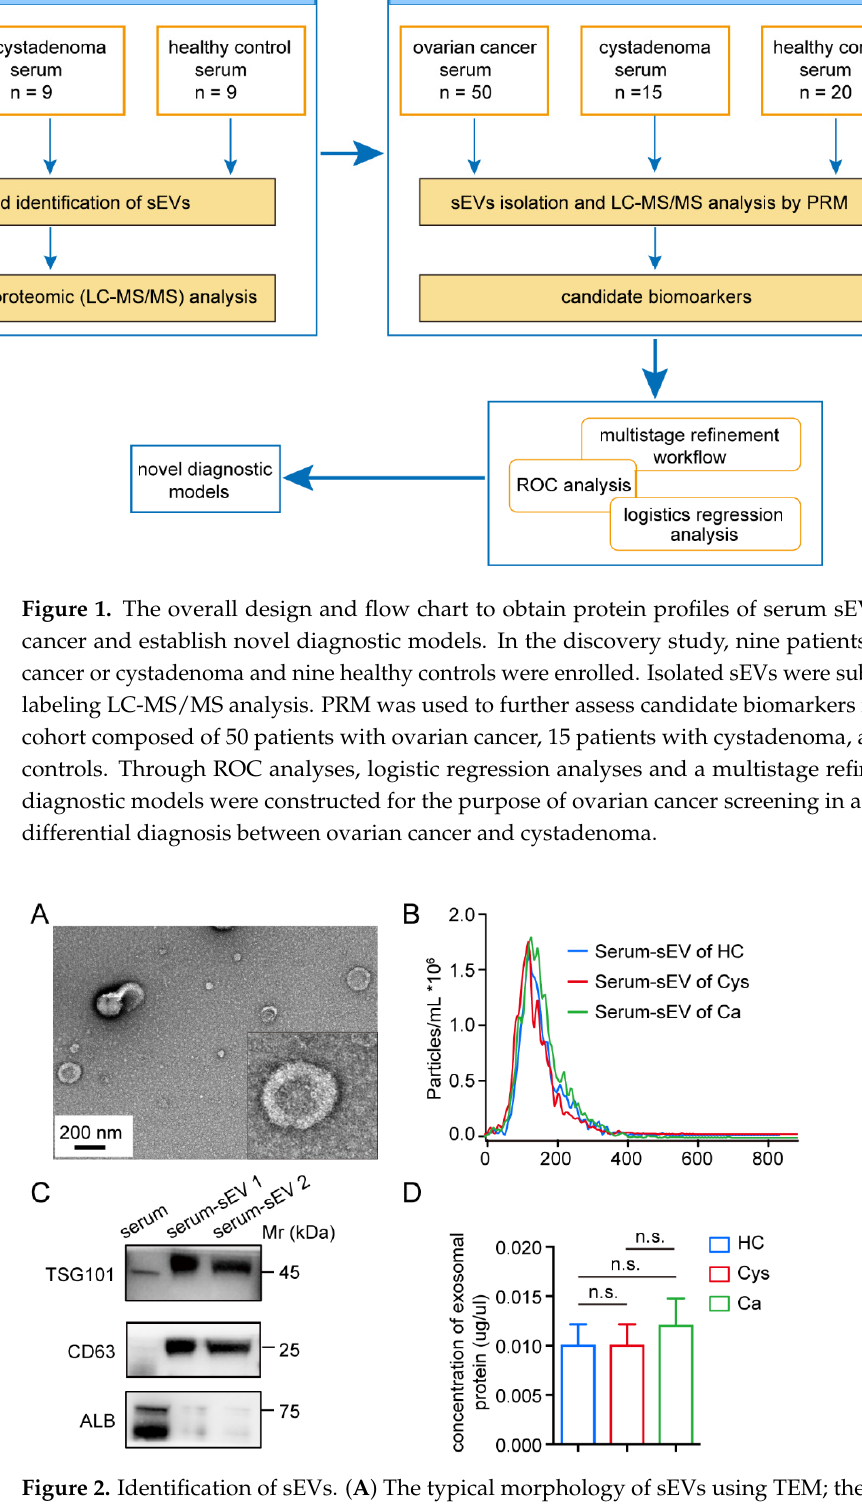
Figure 2. Identification of sEVs. ( A ) The typical morphology of sEVs using TEM; the picture in the lower right corner is the enlarged picture. Scale bar, 200 nm. ( B ) NTA analysis of sEVs from different groups; the horizontal axis represents the diameter of the particle, and the vertical axis represents the number of qualified particles. ( C ) Protein expression of canonical biomarkers of sEVs using western blotting. ( D ) Comparison of the protein concentrations after extraction from different groups of sEVs. n.s., no significance.